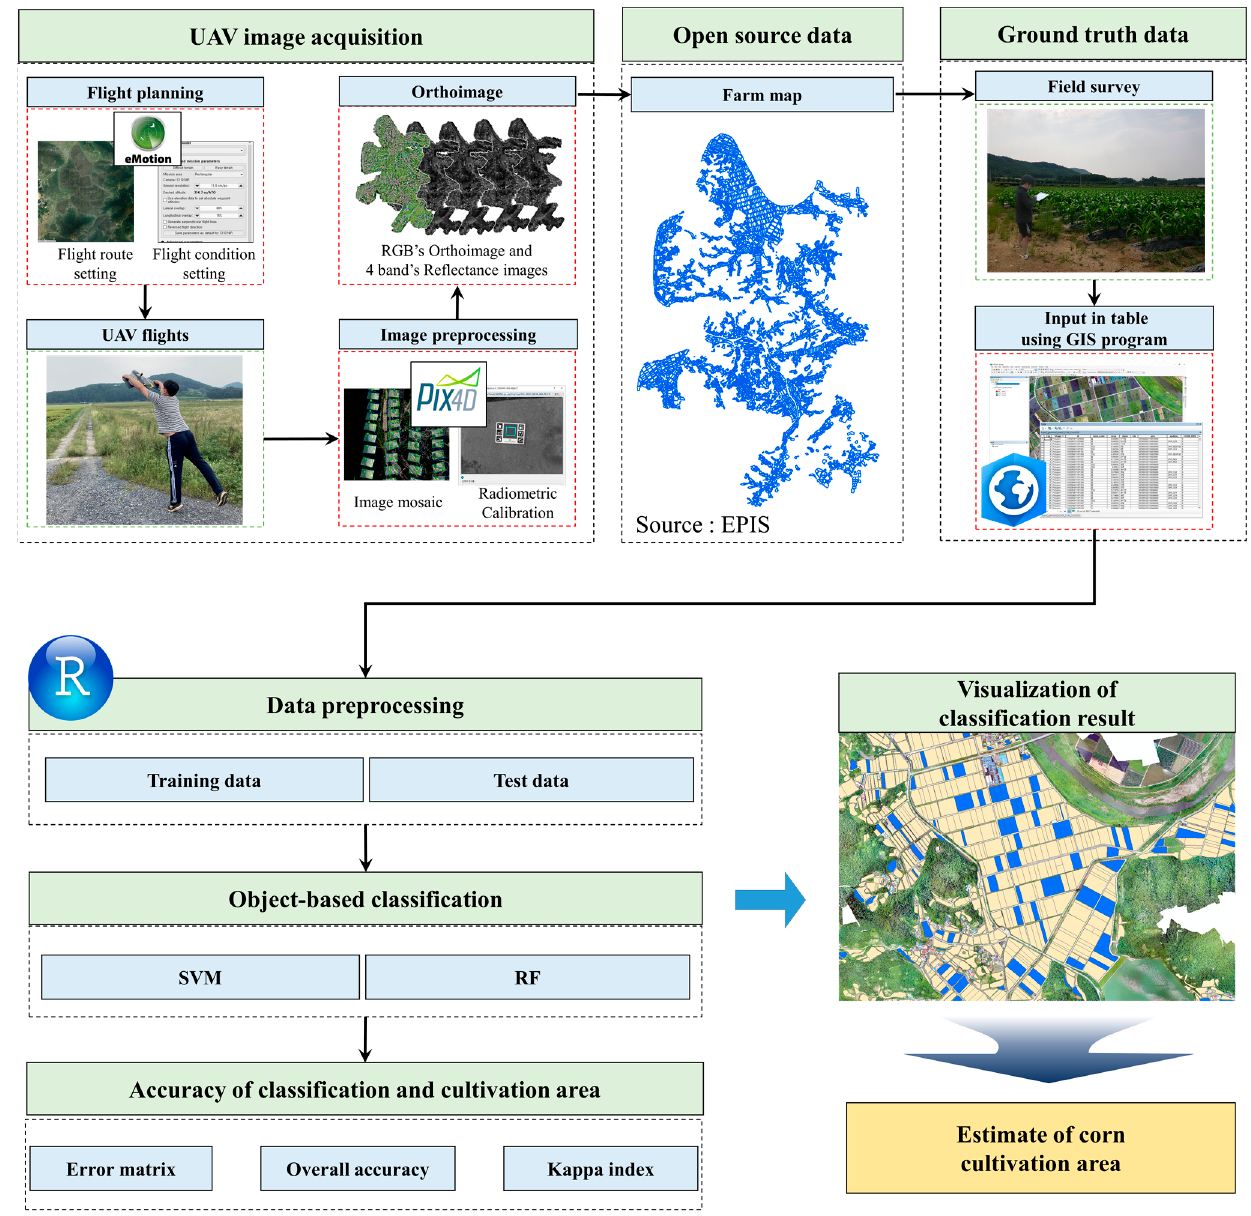
Figure 8. Schematic indicating the UAV image acquisition, Farm Map, field survey, pre-processing, and classification for corn cultivation area estimation.